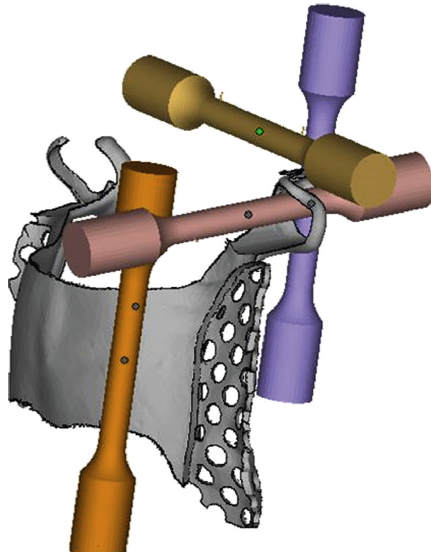
Figure 10: Schematic of a denture framework with different functional